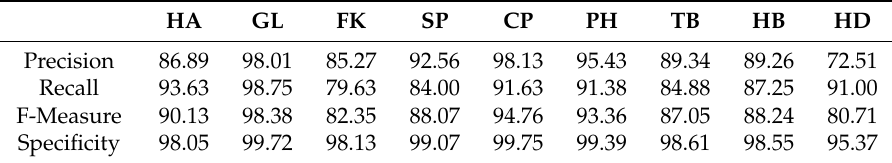
Table A4. Values of precision, recall, F-Measure, specificity of LOSO model SVM IT (all values are expressed in %).